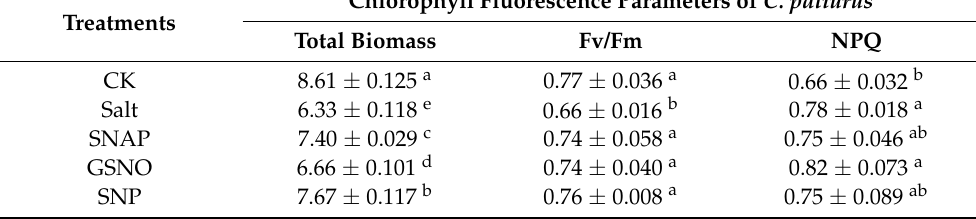
Table 1. Total biomass and chlorophyll fluorescence parameters of C. paliurus in response to different treatments. CK (control, distilled water), salt (100 mM NaCl), SNAP (100 mM NaCl with 0.05